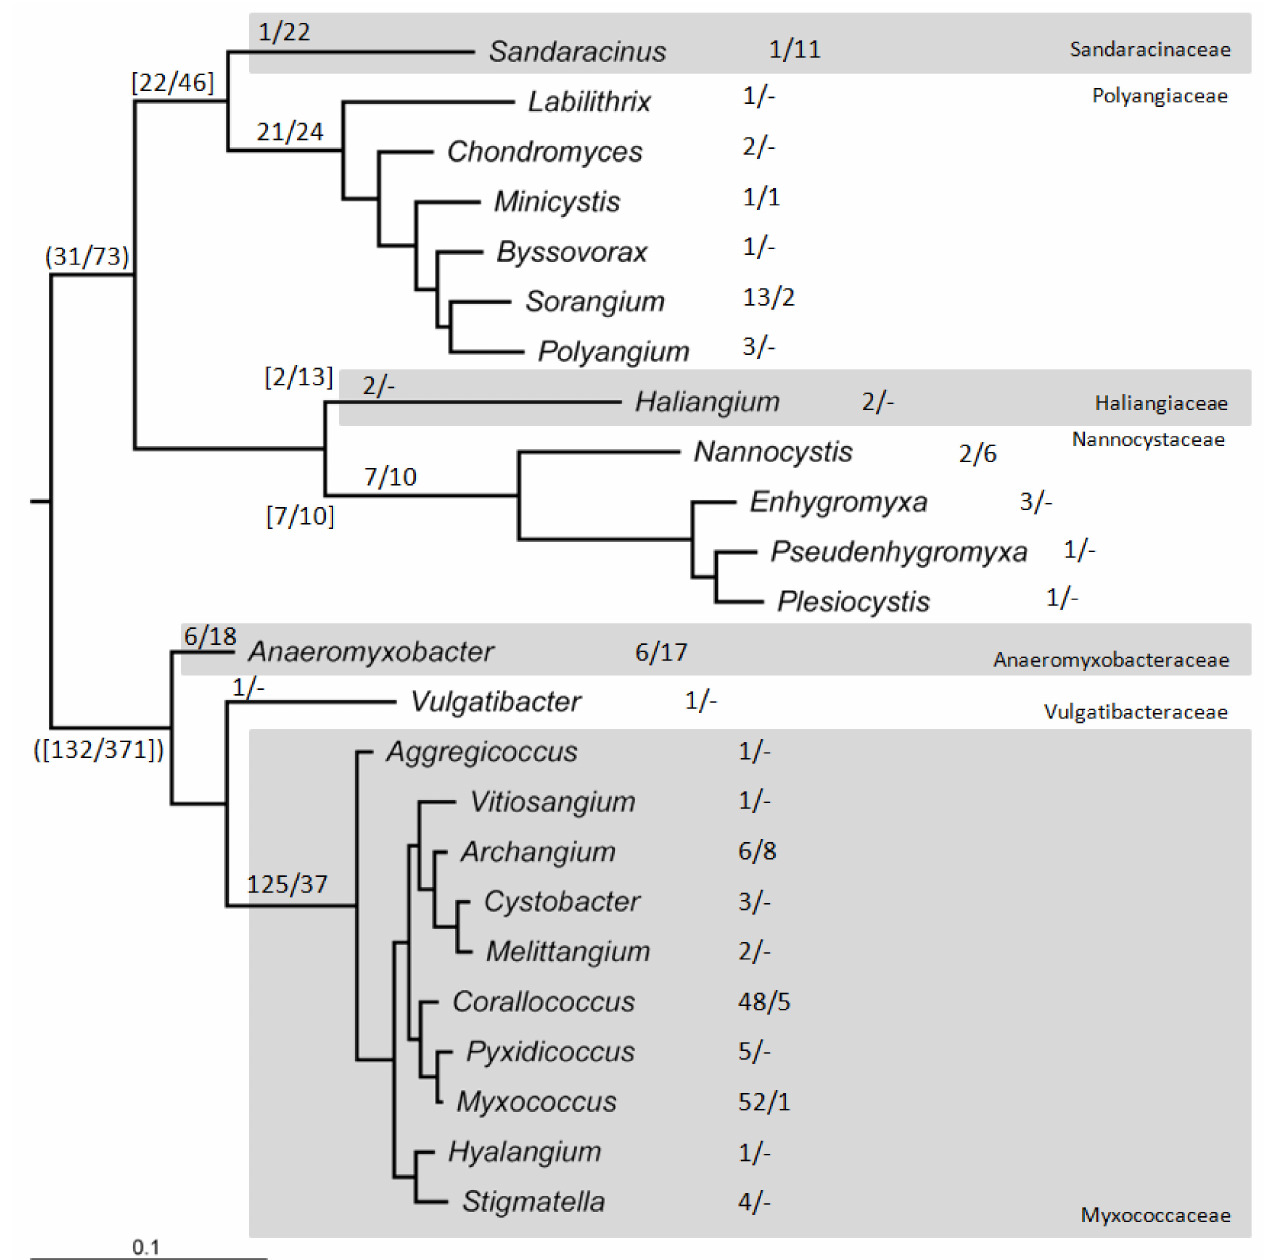
Figure 2. Phylogenetic tree showing the number of genome sequences and MAGs available for sequenced myxobacterial taxa. The tree was produced using 16S rRNA gene sequences from the type strain of each myxobacterial genus (Appendix A). Looking down the tree, families are alternately shaded grey and white. Numbers denote sequenced genomes/MAGs and are shown for each genus, family, order [in square brackets] and class (curved brackets). The Haliangiales and Nanncystales orders each comprise a single family (Haliangiaceae and Nannocystaceae, respectively), while the Myxococcia class contains a single class [Myxococcales]. Not all sequenced organisms/MAGs are taxonomically defined down to the genus, family or order levels (Supplementary Table